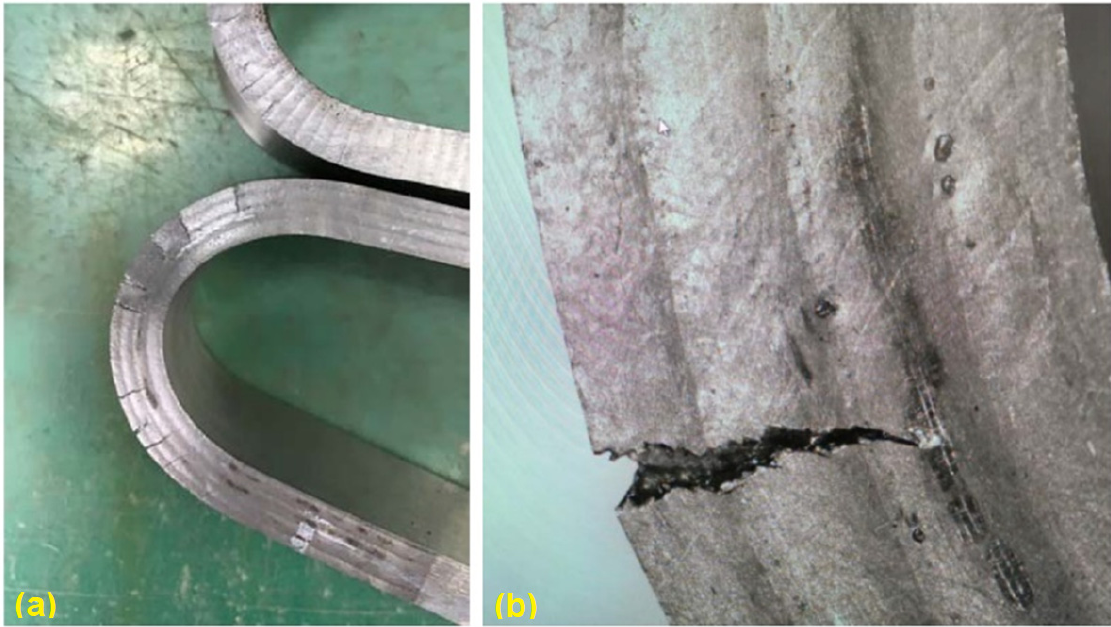
Figure 7. Cracks after side bending tests: test sample ( a ) and cracks ( b ).